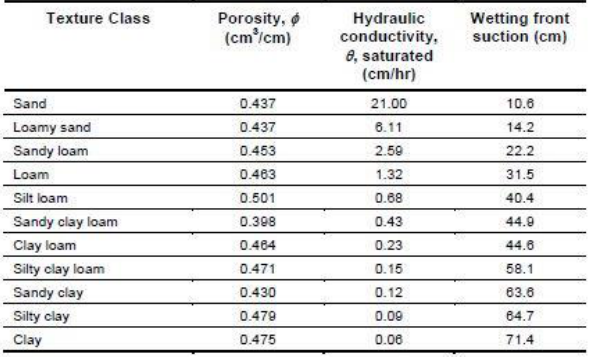
Figure 5: Hyetograph of August 2000 rainfall event Table 2: Green-Ampt Infiltration